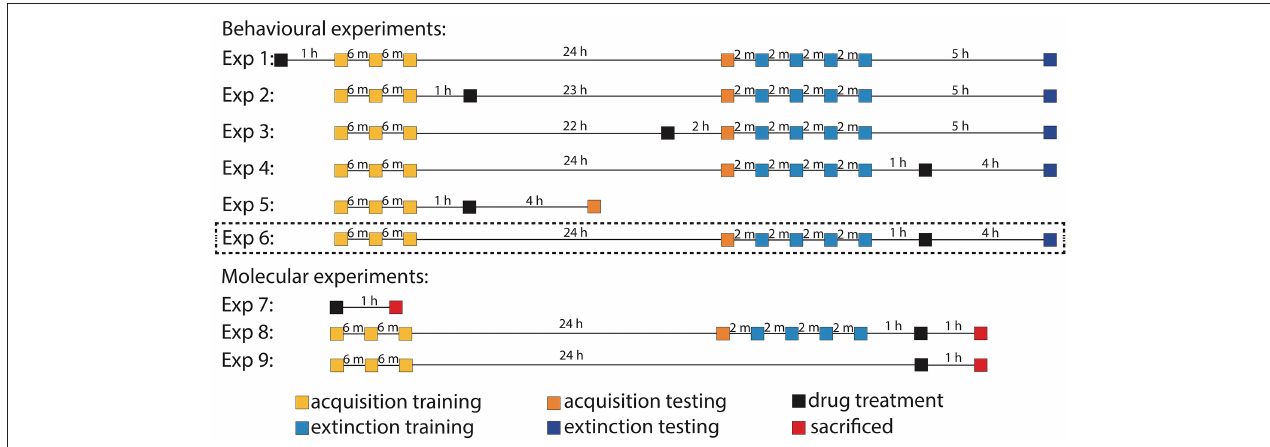
FIGURE 1 | Schematic of training schedules and treatment regimens. Acquisition and extinction trials are presented in yellow and blue, respectively. The darker shades represent test of the same type of memory. The black blocks signify when drug treatment was given, while red blocks show when animals were sacrificed. Note that time is not presented as a linear scale in diagram (h, hours; m, minutes). Dashed lines denote absolute conditioning was used instead of differential.